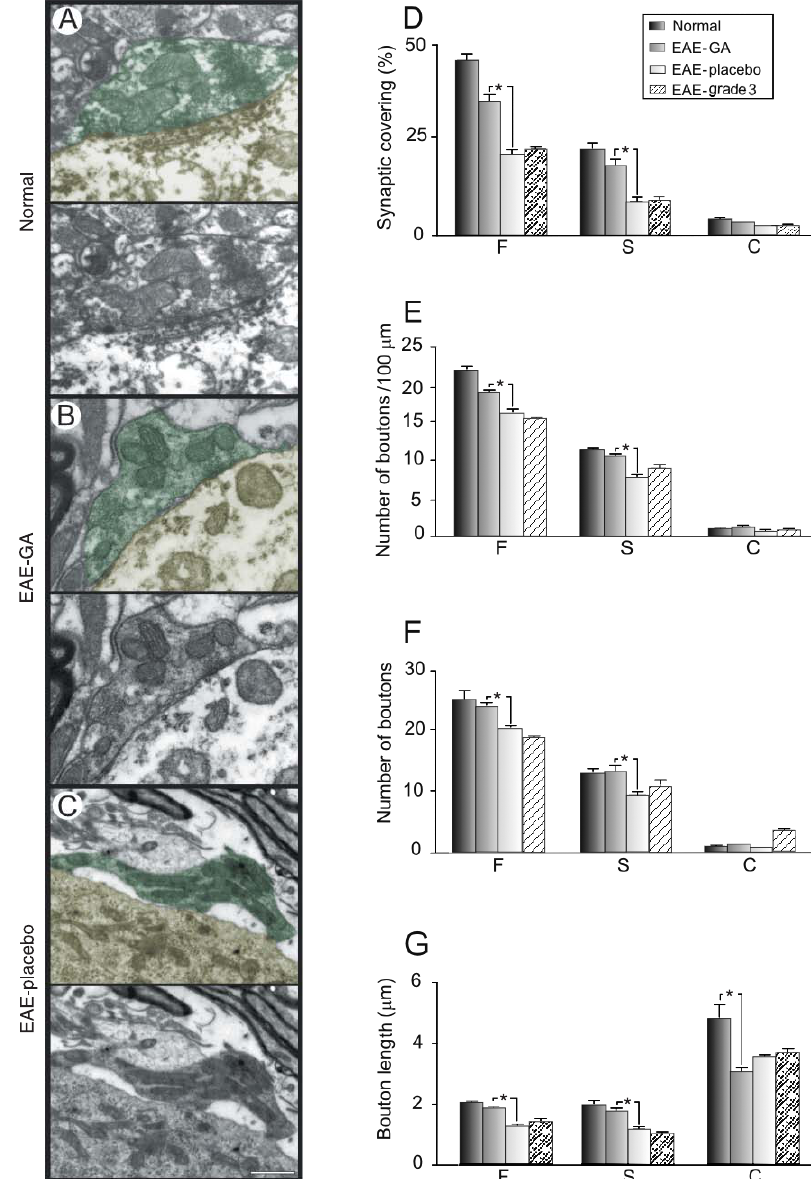
Figure 4. Transmission electron mi- croscope micrographs obtained at the level of the spinal cord ventral